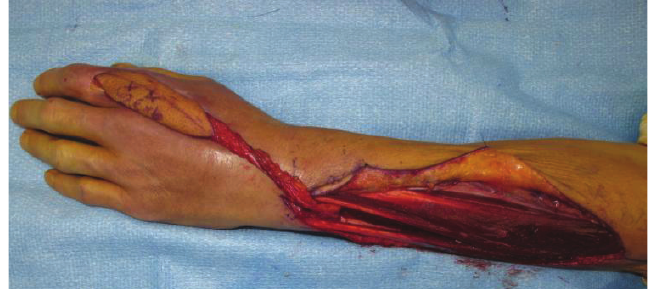
Figure 6. A dissected reverse posterior interosseus artery flap for reconstruction of a dorsal hand defect with exposed tendon after infection. Not the pedicle based at the distal